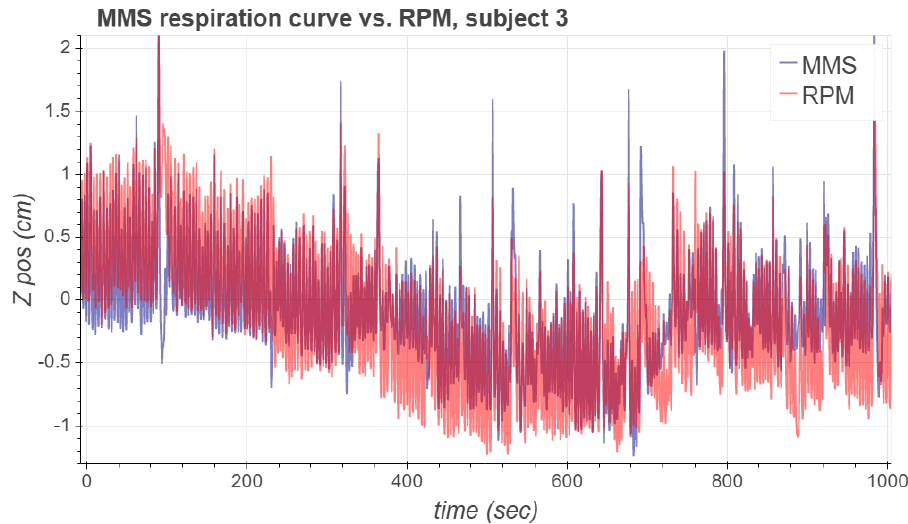
Figure 6. MMS and RPM respiration signals for subject